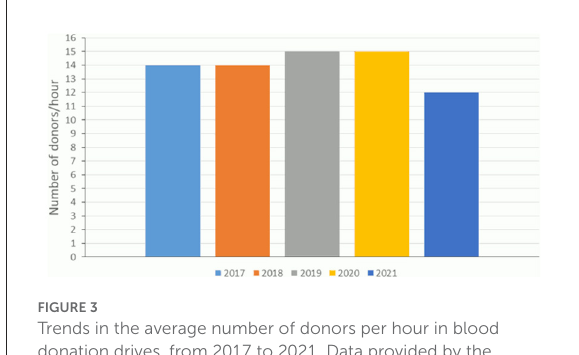
FIGURE3 Trends in the average number of donors per hour in blood donation drives, from 2017 to 2021. Data provided by the French